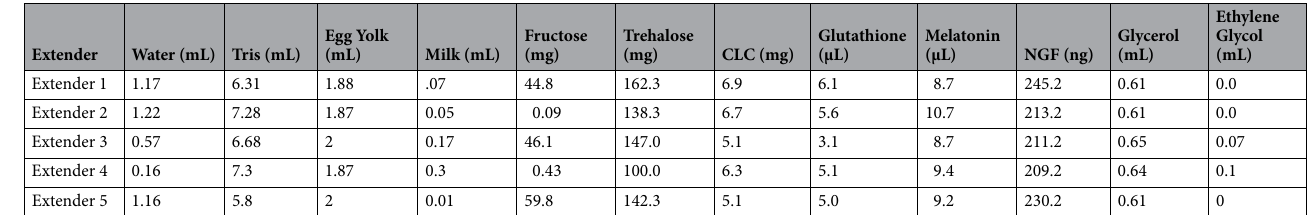
Table 2. The components and concentrations of the five top extenders driven by algorithm